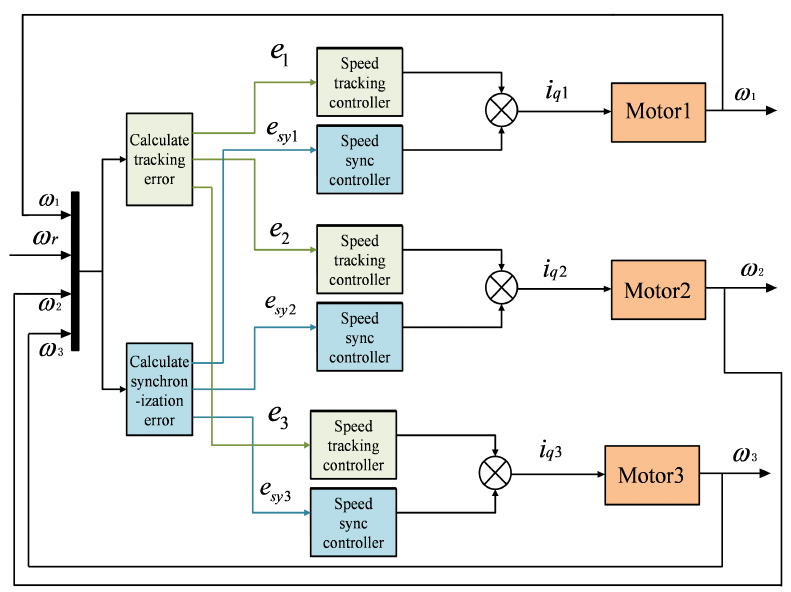
Figure 5. Multi-motor mean-value-coupling synchronous control